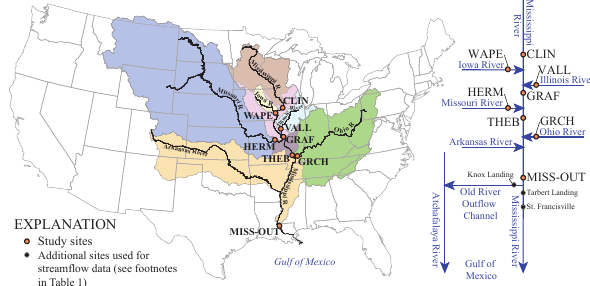
Fig. 1. Map of the continental United States showing Mississippi River basin and study sites, and a schematic line drawing of the rel- ative locations of study sites, major tributaries, and additional